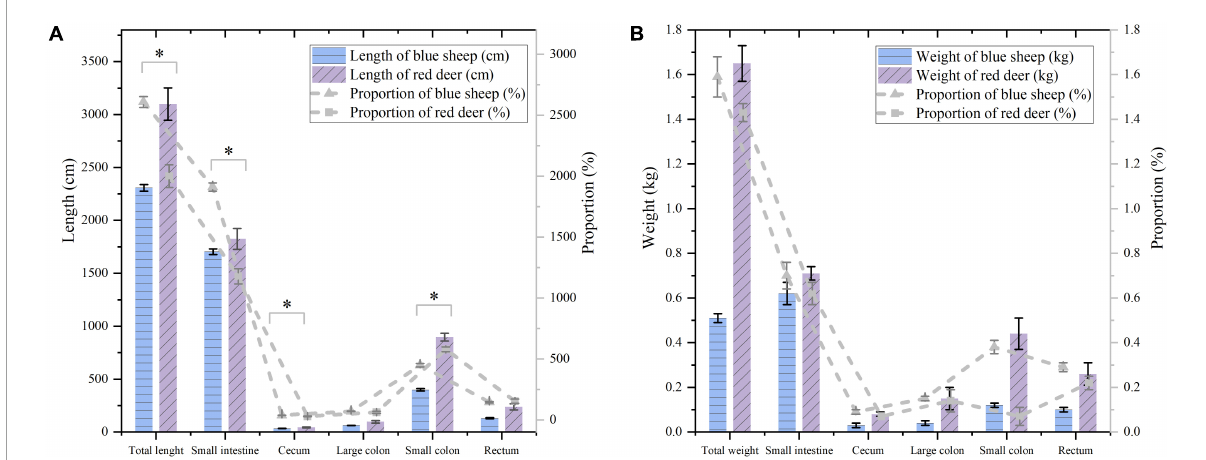
FIGURE5 (A) The length of the intestine and the proportion of the length of the intestine to the body length. (B) The weight of the intestine and the proportion of the weight of the intestine to the body weight (the black and gray error bars represent the standard deviations of the weight and proportion, respectively). ∗ Means there is significant difference between blue sheep and red deer.